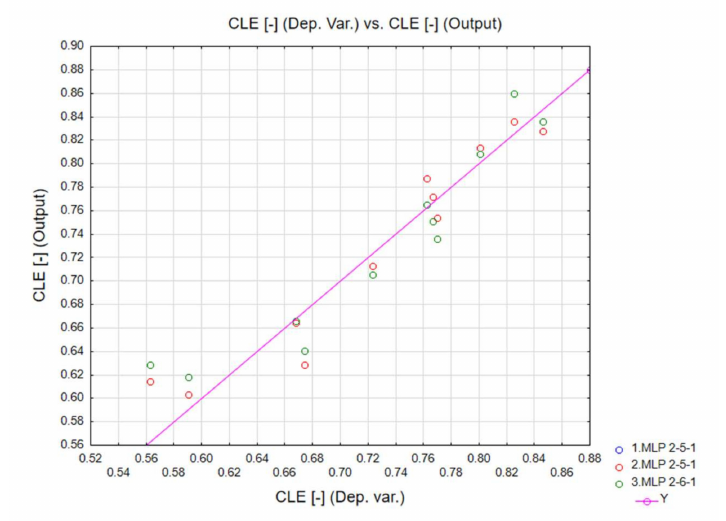
Figure 17. CLE neural network training